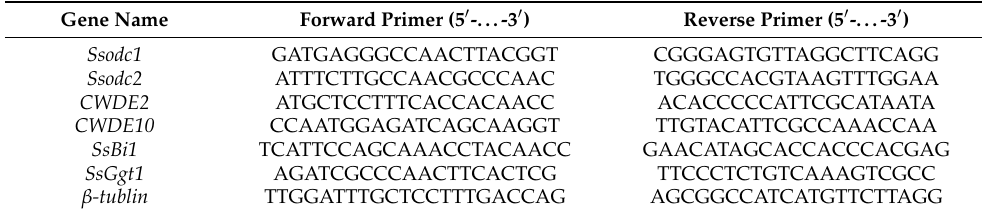
Table 1. Primers used for quantitative real-time PCR of target genes [20].